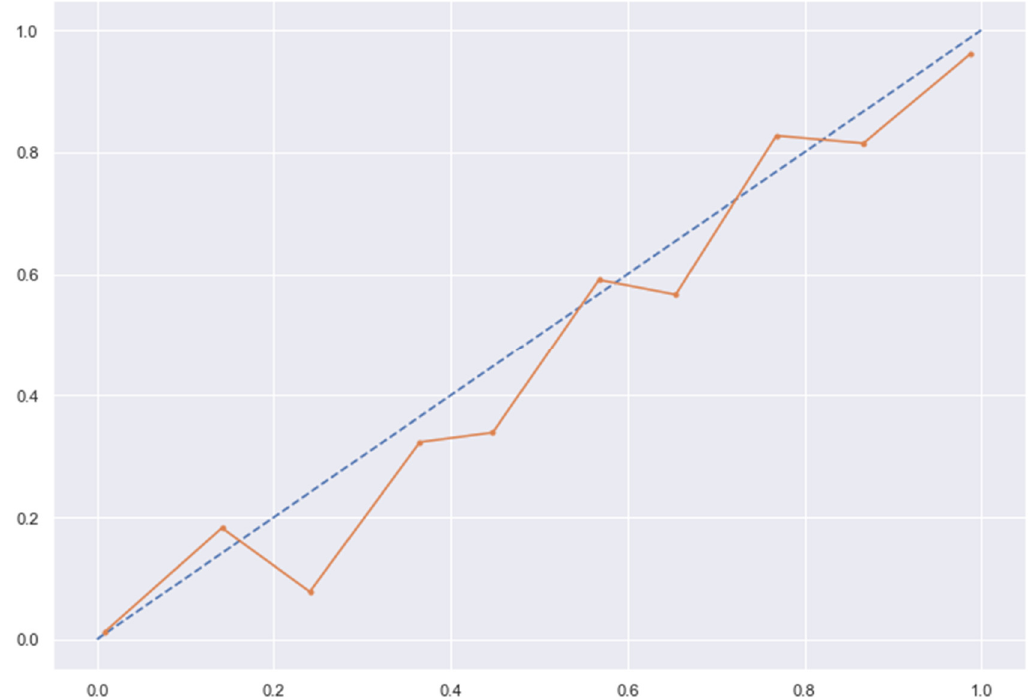
Figure 16. KNN line without calibration vs. after calibration (Ideal fit is represented as blue line). Note: All other models (RFC, GBC, BC) were overfitting the data and had a balanced accuracy score of 1.